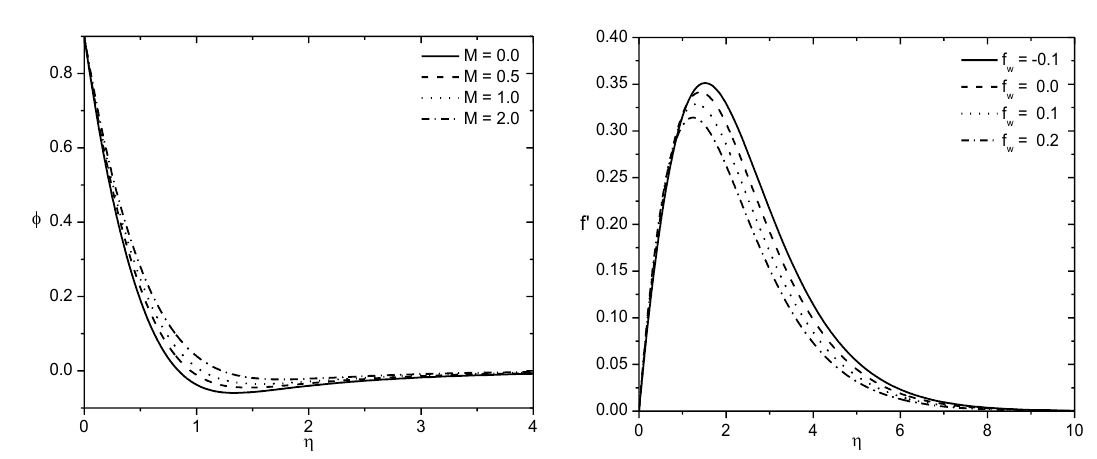
Figure 3. Effet of M on the Solid volume fraction Figure 4. Effet of f w on the